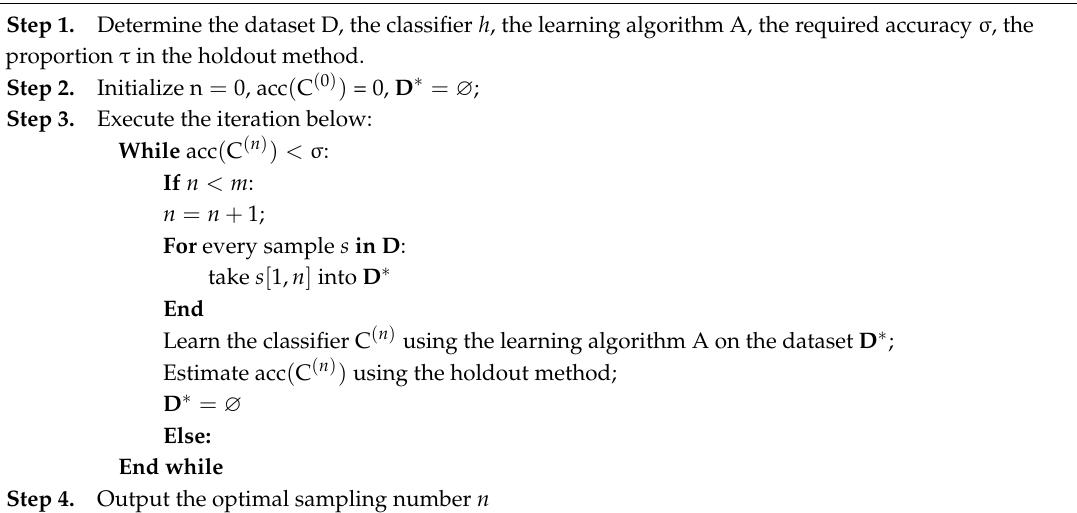
Algorithm 1 Algorithm of the optimal